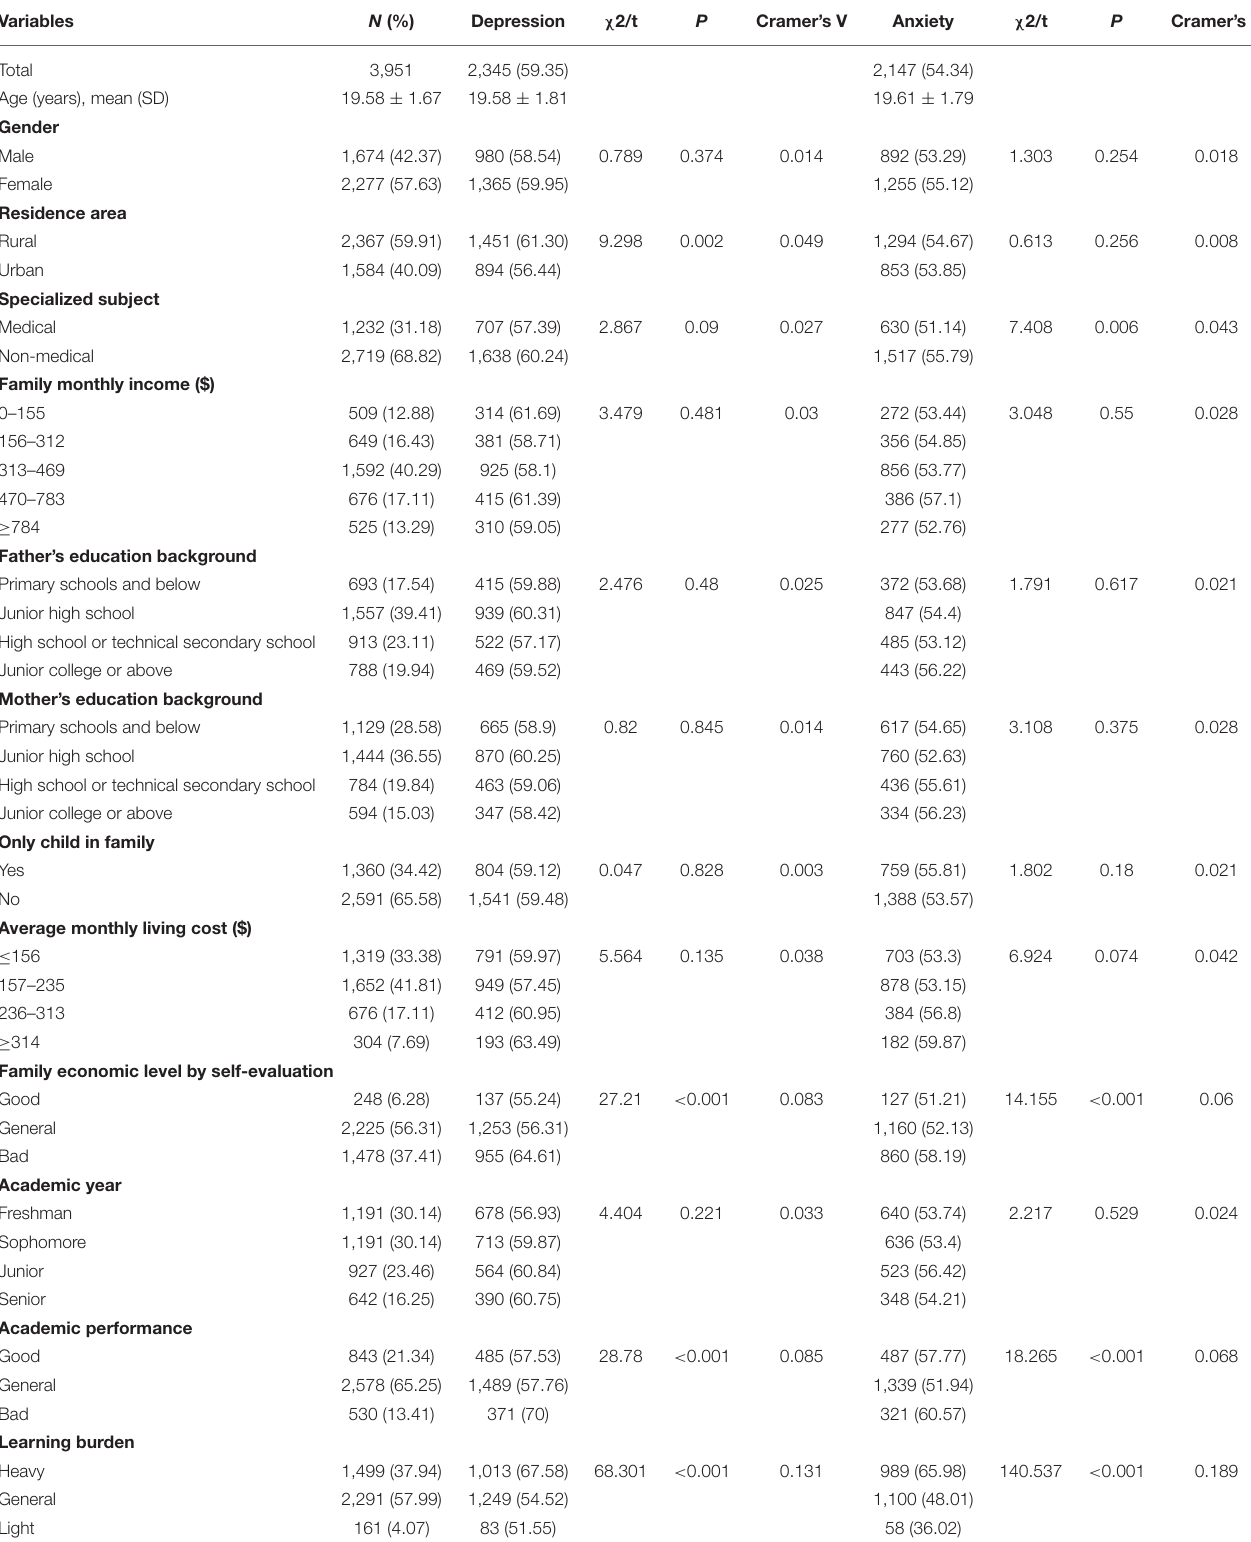
TABLE 1 | The anxiety and depression of college students in facing the epidemic of COVID-19.